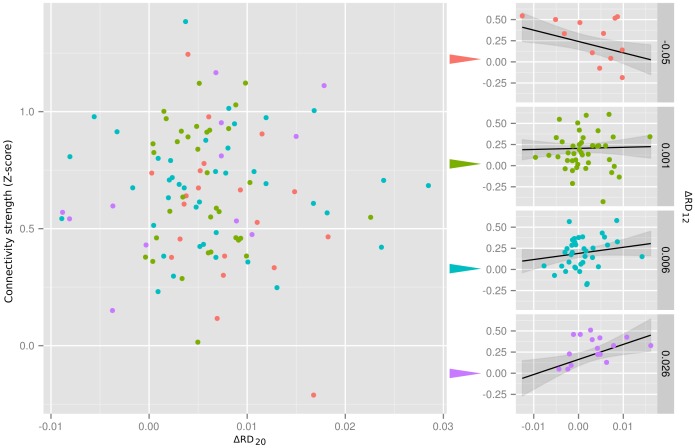
RDI effect in case of a demonstrative connection: occipital fusiform gyrus (A = 20) - prefrontal gyrus (B = 12).On the left, the partial residuals for  from the model defined by Eq. (8) (dependent variable: connectivity data of the healthy control population (N = 105), without nuisance signal regression (NOREG)) are plotted against . Although the model reveals no significant relationship (t = −1.46,p = 0.15) between connectivity strength and , the  interaction effect is significant (t = 3.31, p = 0.0013), implying that the effect of  on connectivity strength differs depending on the value of . This is demonstrated by dividing the data into four groups based on the value of  (color-coded on the left plot) and visualizing the corresponding cross-sectional CCPR (component and component-plus-residual) plots (on the left). Mean value of  corresponding to the cross-section is indicated. Partial residuals are plotted with colored dots corresponding to the cross-section group. The corresponding regression line estimated from the full model fit and the corresponding 95% confidence interval is displayed in black and gray, respectively. The horizontal and vertical axes of the cross-sectional CCPR plots are the same as those of the partial residual plot on the left. Cross-sectional CCPR plots imply that in each group the relationship between  and partial residual connectivity strength is significant but the regression lines have different slopes, which makes this latent relationship not observable without accounting for the interaction of the regional displacement covariates.